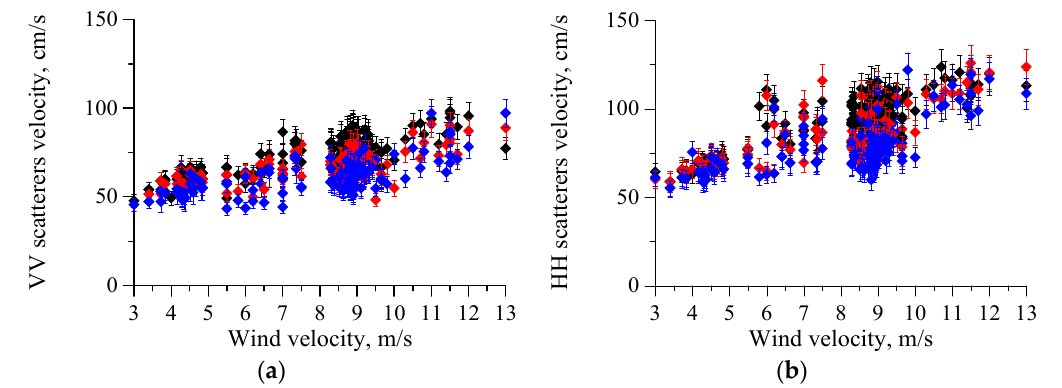
Figure 4. ( a ) The scatterer velocities at VV and ( b ) HH polarizations vs. the wind velocity. Black symbols—S-band, red—C-band, blue—X-band.